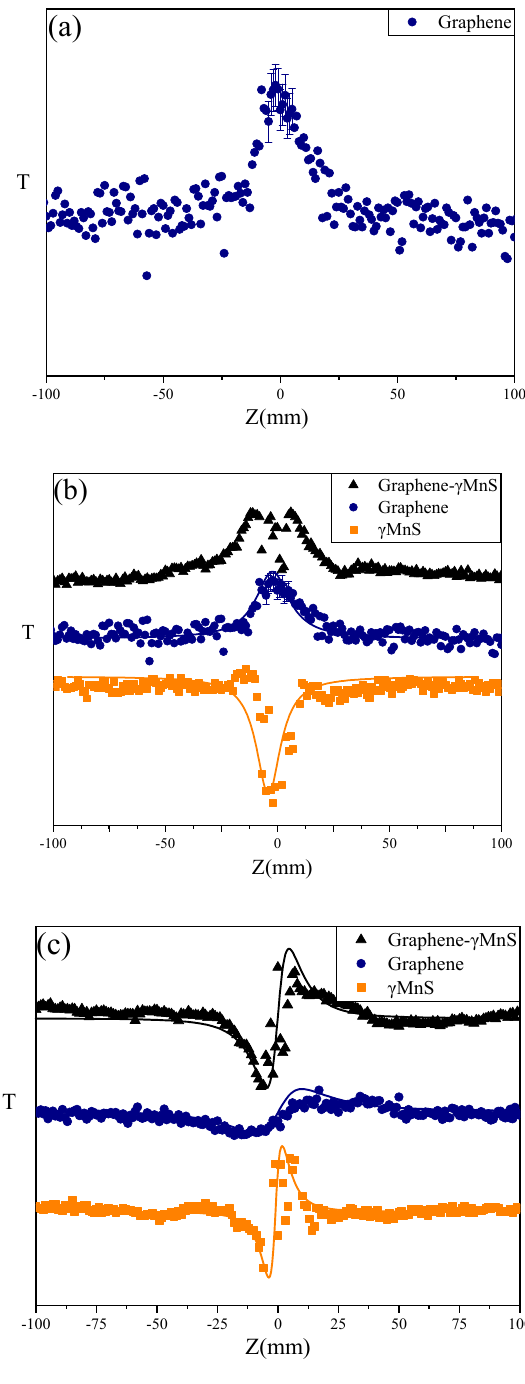
Figure 7. ( a ) OA Z-scan curves of graphene ( b ) OA Z-scan curves of graphene- γ MnS, graphene, and γ MnS at 15.1 GW·cm − 2 . ( c ) CA/OA Z-scan curves of graphene- γ MnS, graphene, and γ MnS at 15.1 GW·cm − 2 .